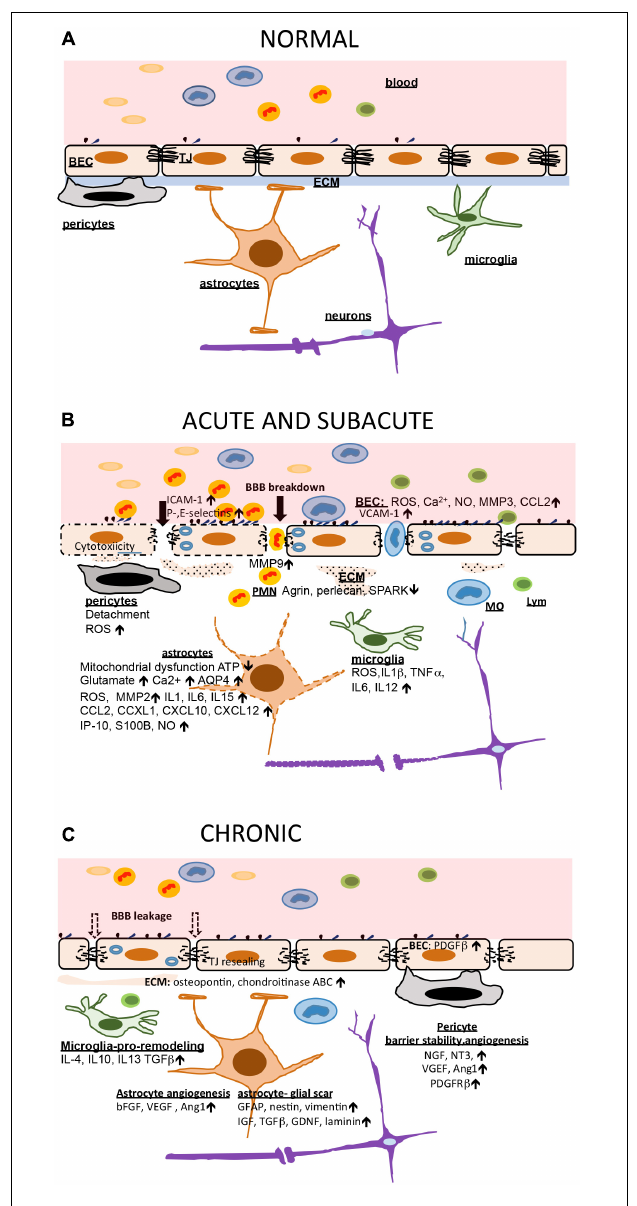
FIGURE 1 | Blood brain barrier (BBB) and neurovascular unit (NVU) in ischemic injury and post-stroke recovery. (A) In healthy conditions, the BBB is intact and other NVU components, including the extracellular matrix (ECM), support and preserve brain homeostasis. (B) Cessation of blood flow triggers a chain reaction at the BBB and NVU. The early events are mostly characterized by cytotoxicity, mitochondrial dysfunction and accumulation of ROS which further cause BBB breakdown (tight junction, TJ, disruption), neuronal injury guided by astrocytes, and triggering an acute inflammatory response. Brain endothelial cells (BEC) increase adhesion receptor expression allowing leukocyte (predominantly polymorphonuclear neutrophils; PMNs) entry which adds to BBB injury. Microglia and astrocytes produced large amount of proinflammatory cytokines and chemokines amplifying inflammation. Early pericyte detachment support BBB instability and breakdown. This support vasogenic brain edema formation. (C) The subacute and chronic phase of stroke is characterized by increased second wave of inflammation with monocyte (MO) and lymphocyte (Lym) entry but